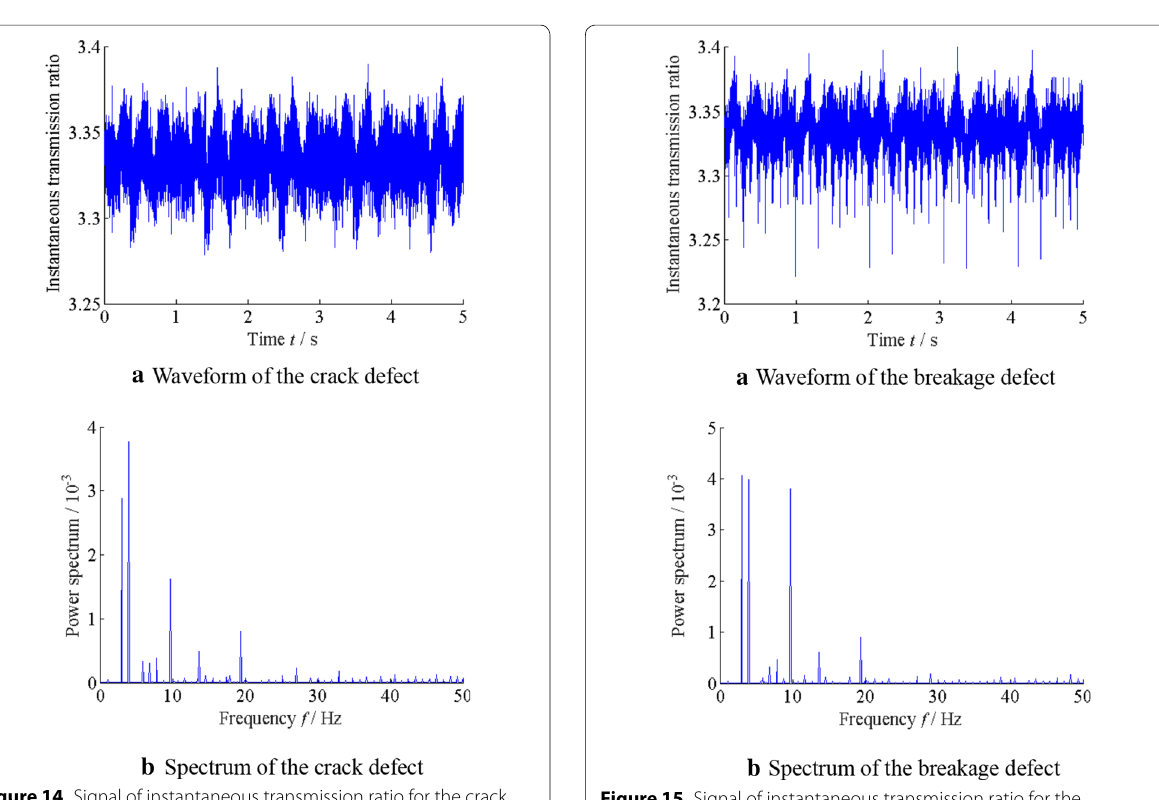
Figure 15 Signal of instantaneous transmission ratio for the breakage